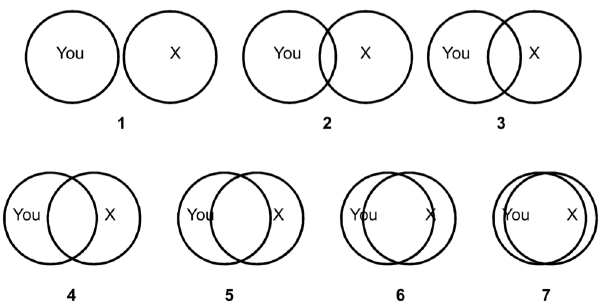
Fig 1. The 'Inclusion of the Other in the Self' (IOS) task. Adapted and changed for our online implementation from AAS ([1], Fig 1, p. 597). Respondents are asked to select the pair of circles that best describes their relationship with X. AAS speak of ‘ Self ’ and ‘ Other ’ , whereas we use the terminology ‘ You ’ and ‘ X ’